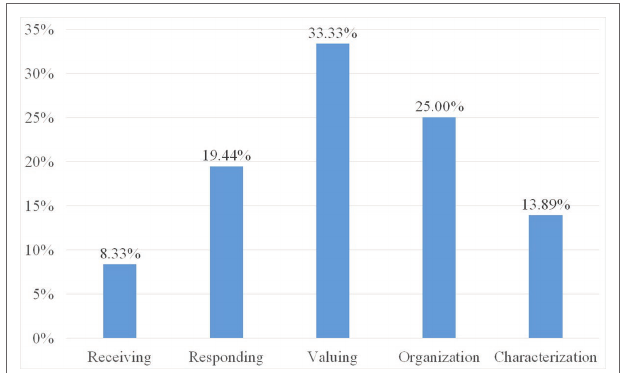
FIGURE 2 | The retention status after the end of the